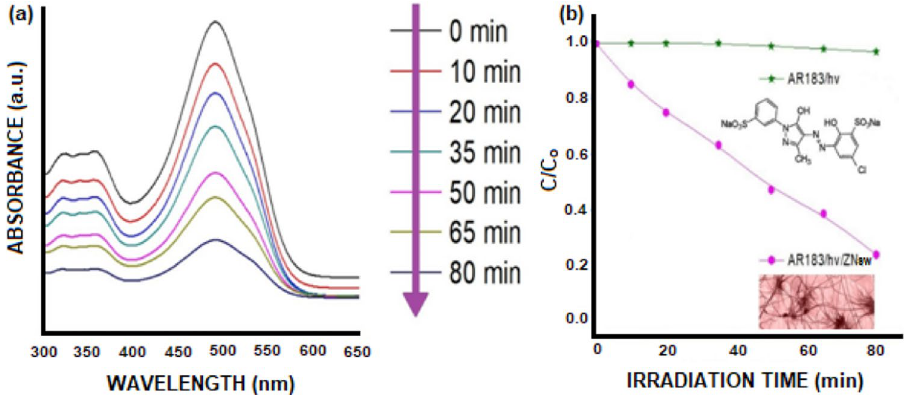
Figure 4. ( a ) Photodegradation of Azo Dye AR183 with ZNsw and ( b ) Change in concentration as a function of time on irradiation of an aqueous solution of Azo Dye AR183 in the absence and presence of